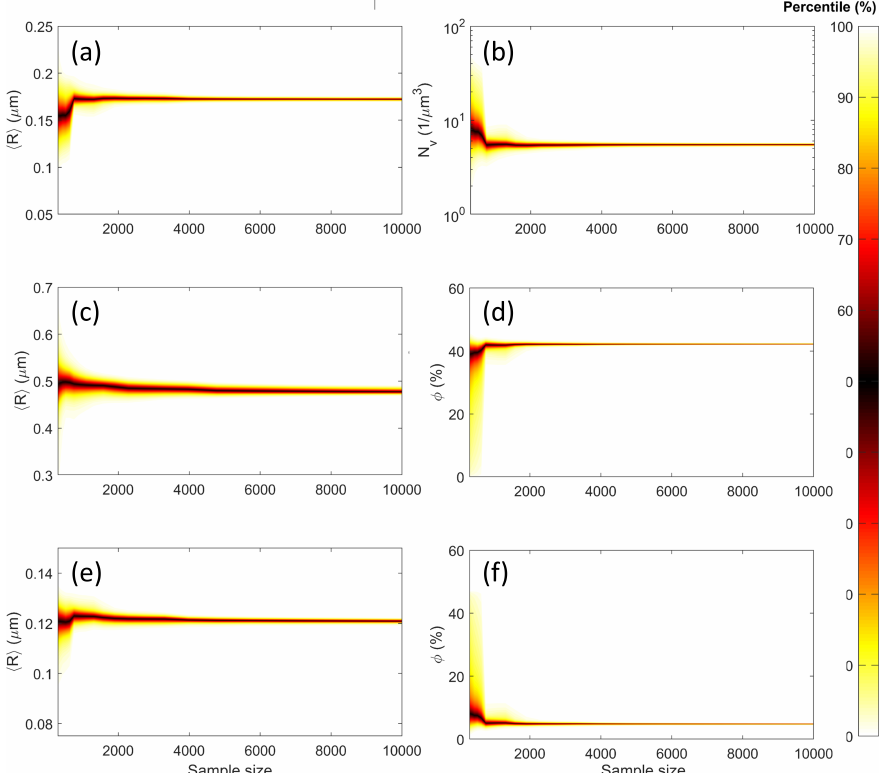
Figure 12. Variation in predicted particle statistics as a function of sample size. ( a , b ) show the variation in percentiles for the mean particle radius and particle concentration considering the entire dispersion. ( c , d ) compare the mean particle radius and particle volume fraction for the primary particles, whilst ( e , f ) show the variation in mean particle radius and volume fraction for the secondary particles.